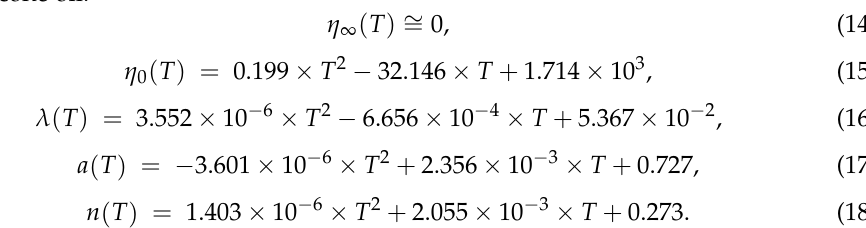
Figure 4. Estimated model parameters (red dots) and fitted model parameter curves (dotted lines) for ( a ) zero ‐ shear dy ‐ namic viscosity, ( b ) relaxation time, ( c ) transition control factor and ( d ) power law index.